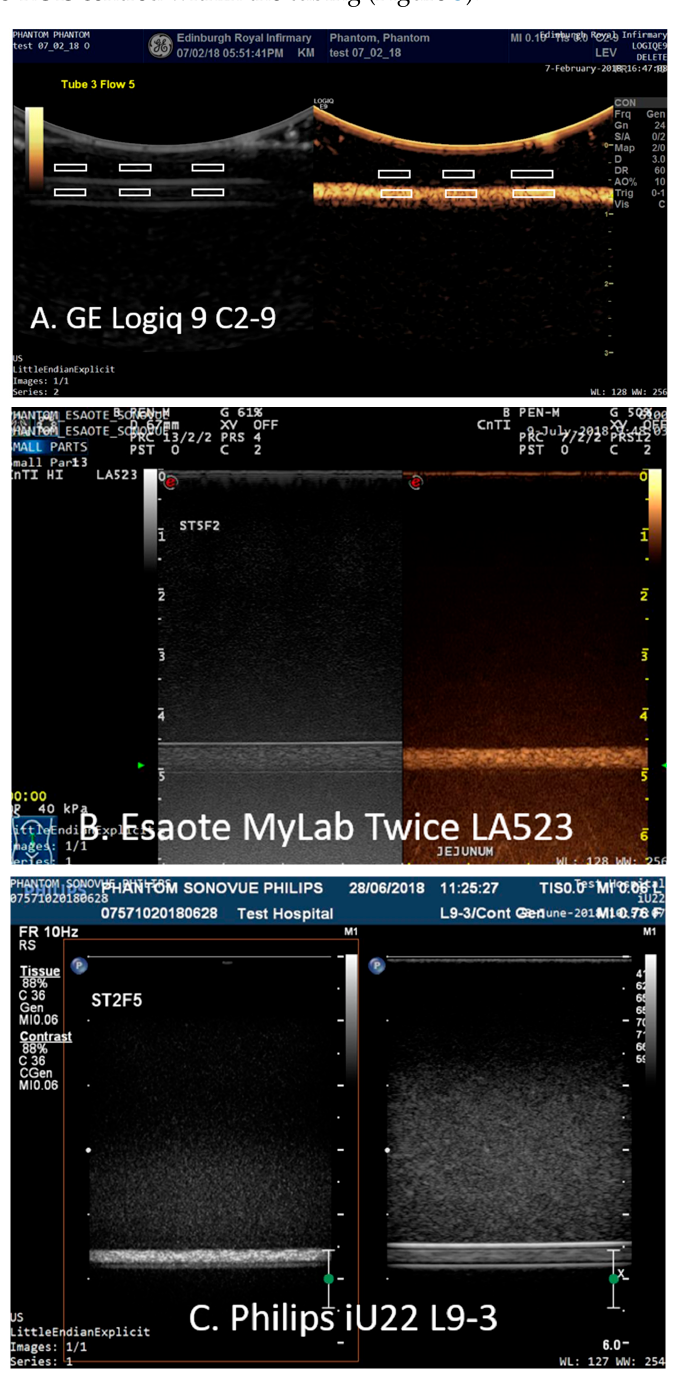
Figure 3. Images acquired from 1.6 mm tubing ( A ) 1 cm depth SonoVue-filled tube imaged using the GE Logiq9 C2-9 transducer with ROIs highlighted; ( B ) 5 cm depth SonoVue-filled tube imaged using an Esaote MyLab Twice LA523 and ( C ) 8 cm depth DEFINITY ® -filled tube using a Philips iU22 L9-3.